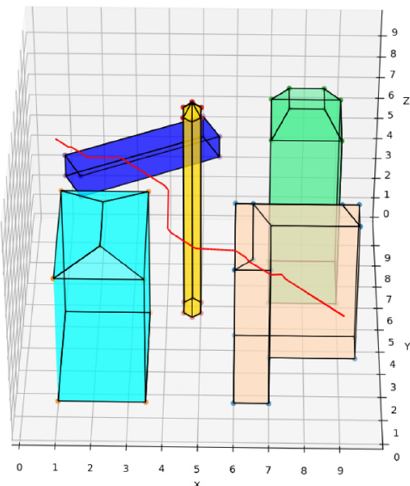
Figure 9. UAV route deploying traditional artificial potential field route planning algorithms in disturbance-free scenarios.